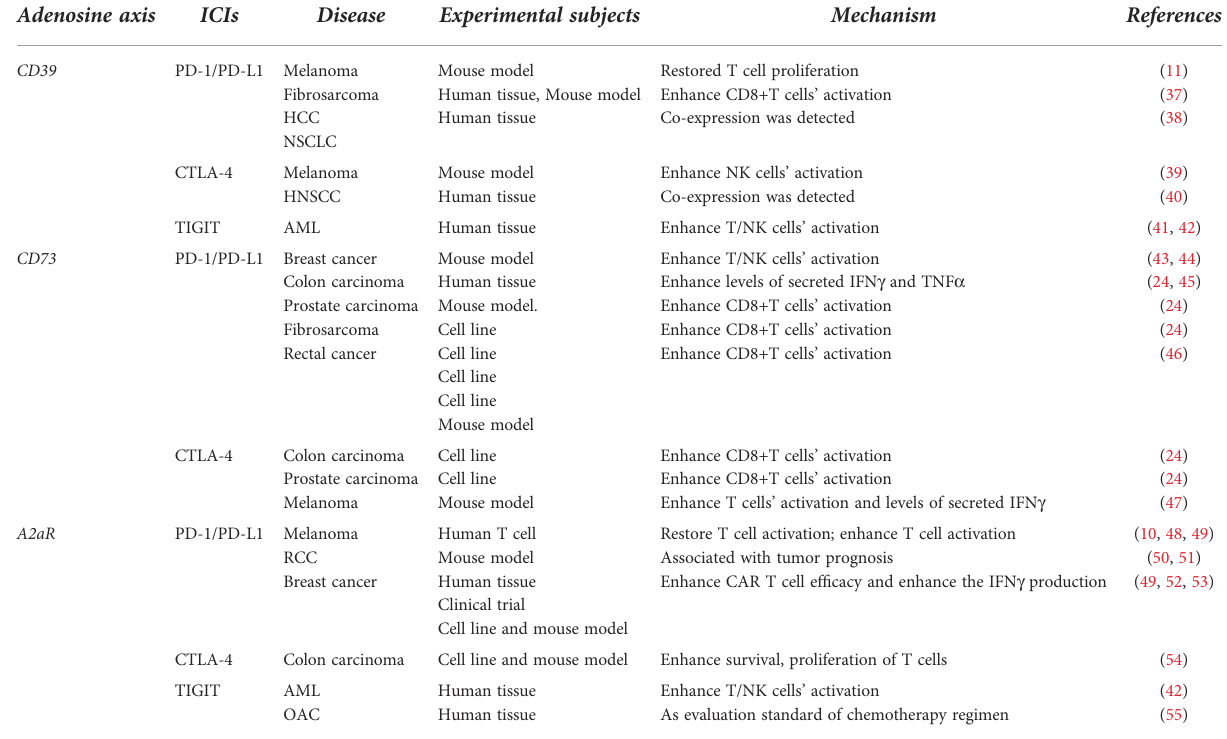
TABLE 1 Application of different targets on adenosinergic axis combined with various immune checkpoints in tumor therapy. Adenosine